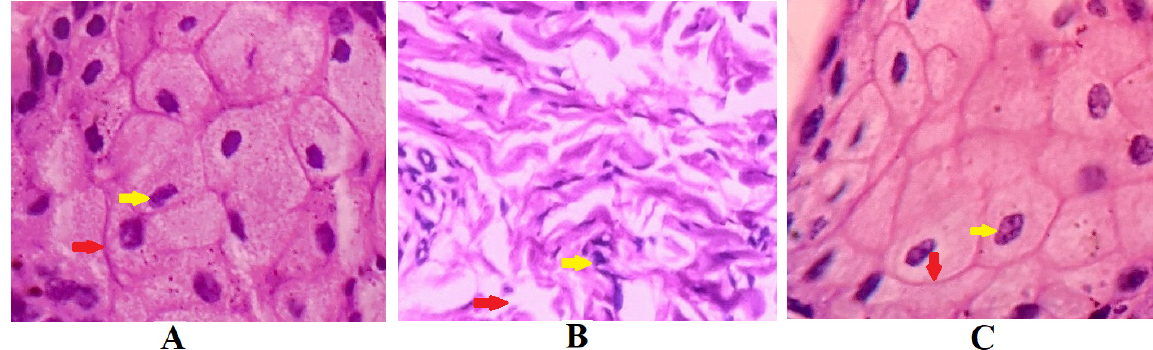
Figure 11. Histopathological examination of sections of sheep nasal mucosal membrane. ( A ) Negative control: hematoxylin and eosin staining of nasal mucosa membrane applied with phosphate buffer reveal unaffected nasal cells with intact basement membranes (red arrows), as well as undamaged glandular cells with clear nuclei (yellow arrow). ( B ) Positive control: nasal mucosa treated with isopropyl alcohol suffered severe cellular and histological damage. The treatment with isopropyl alcohol disrupted basement membrane (yellow arrow) and loss of nucleus of glandular cells to form a multinucleated cells. ( C ) Test: nasal in situ gel of darunavir when exposed to nasal tissues of the sheep showed intact basement membrane (red arrow) and normal arrangement of the glandular cells with well-defined nuclei (yellow arrow), indicating no signs of toxicity of the formulation.